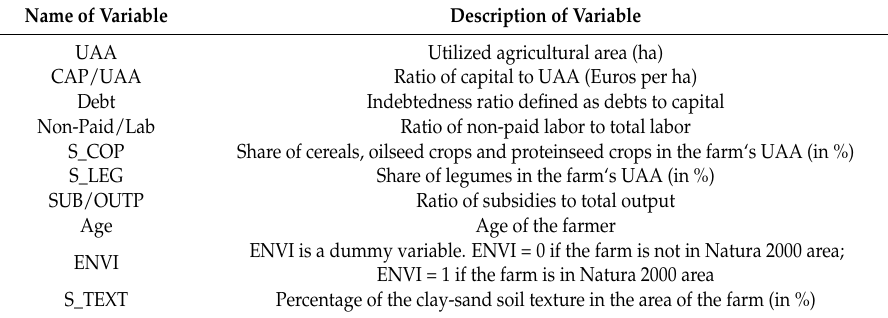
Table 2. Variables used to explain input